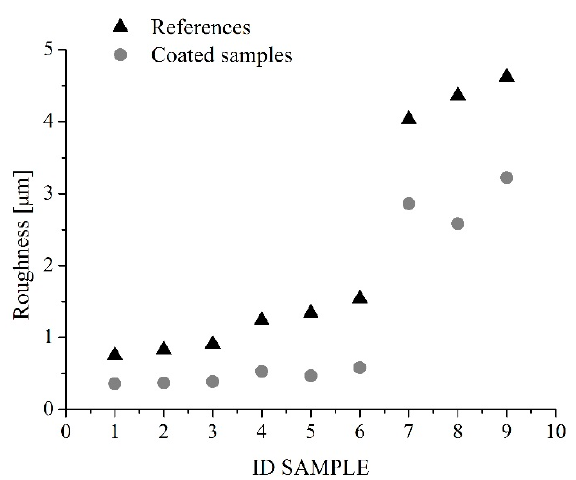
Figure 3. Roughness values of samples before (triangles) and after (circles) the application of the coating.